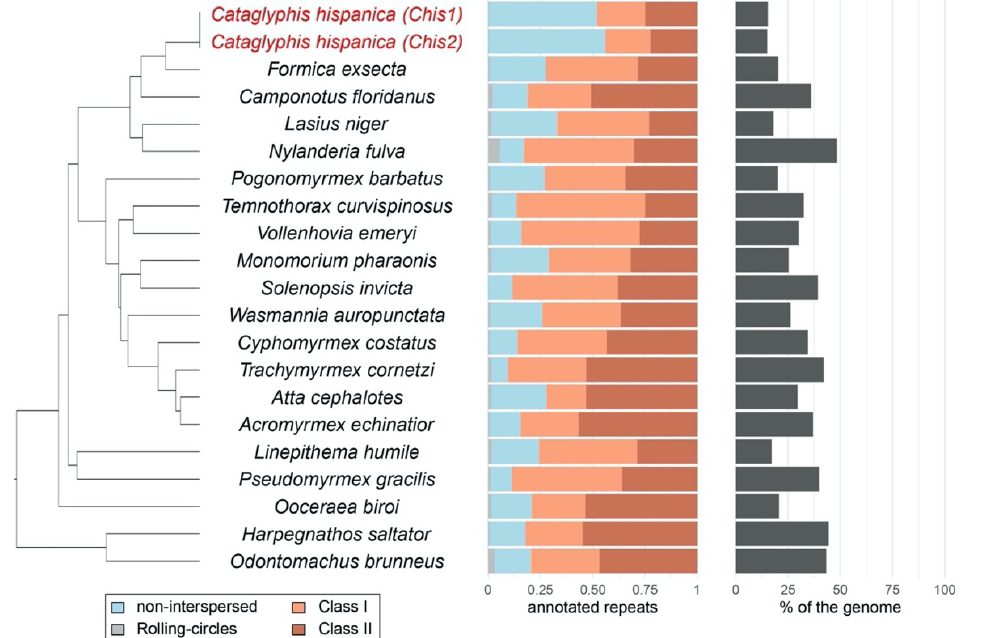
Figure 5: Summary of the repetitive elements’ categories annotated in 20 different ant species using our custom pipeline. The ratios of the major categories of repetitive elements identified in each species is shown on the left. The total proportion of repetitive elements found in each genome is shown on the right. Species are ordered accordingly to their phylogenetic positions inferred from a concatenated alignment of single-copy